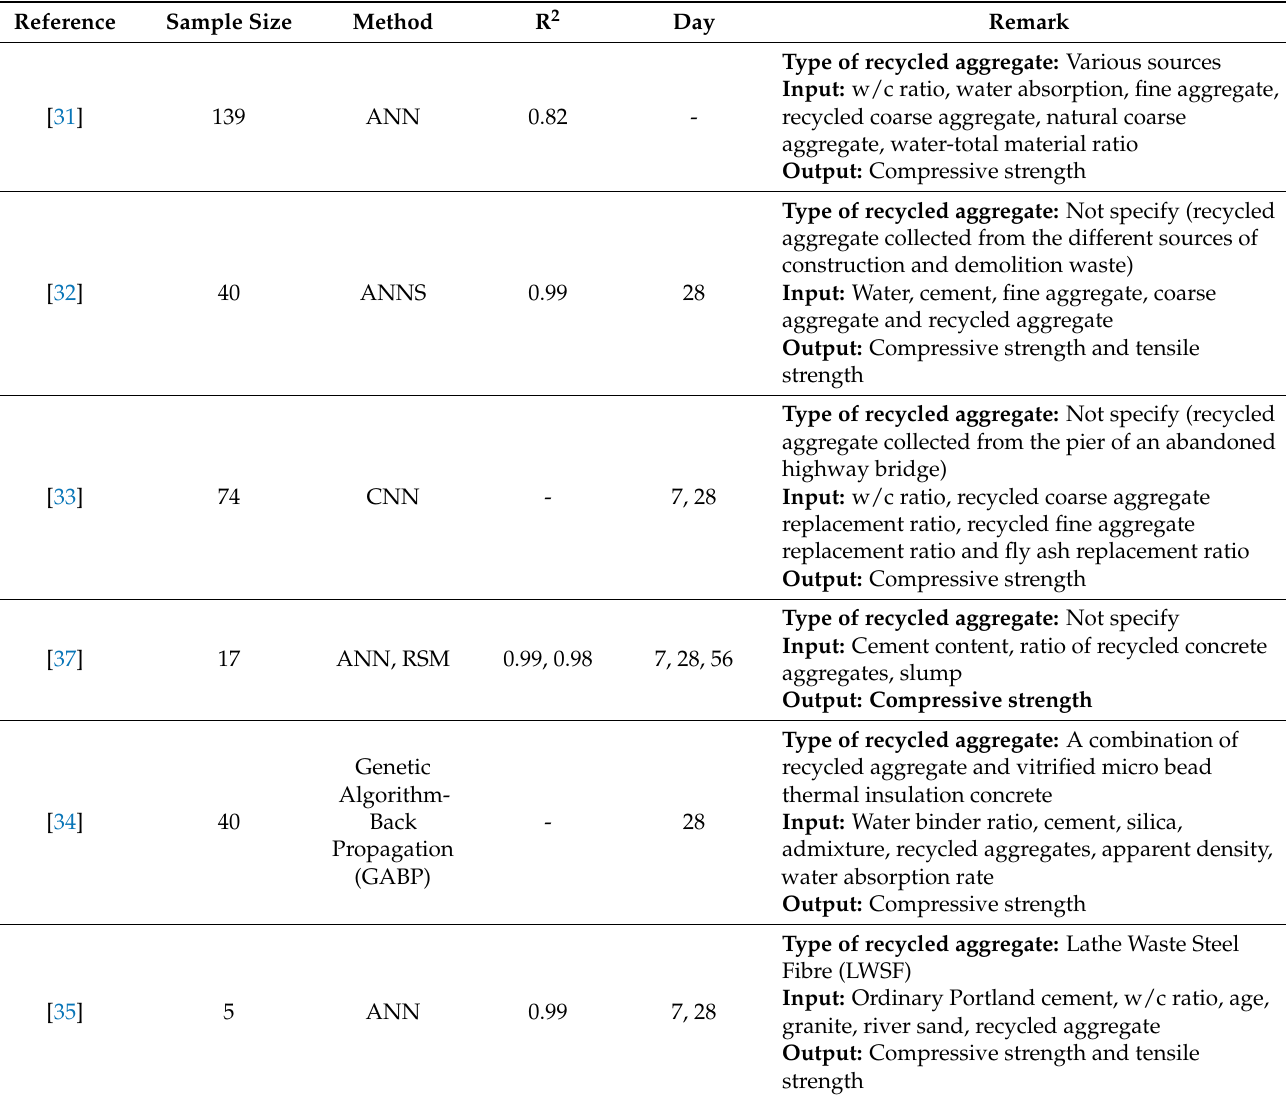
Table 7. Summary of the previous works on prediction model of recycled